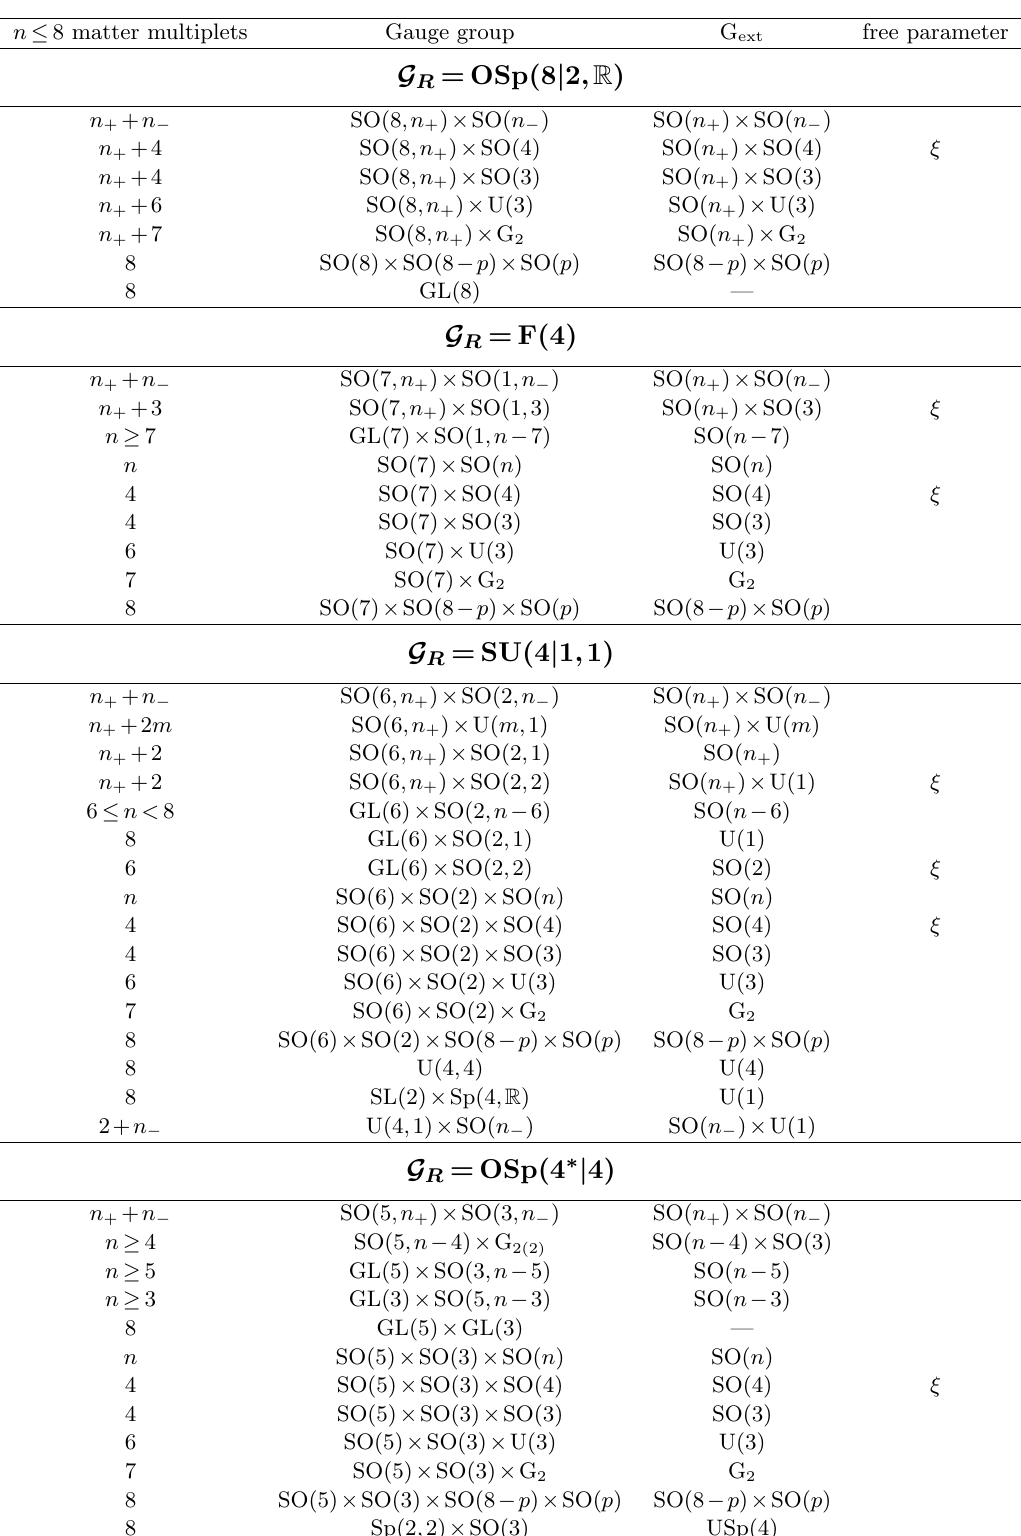
Table 2. = (8 ; 0) AdS 3 vacua preserving a global SL(2 ; R ) L N